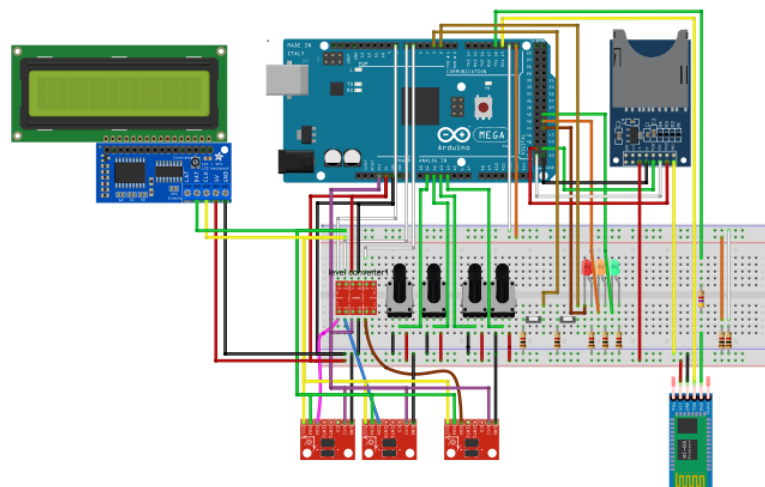
Figure 1. Design of the electronic or control system implemented in the Fritzing software.